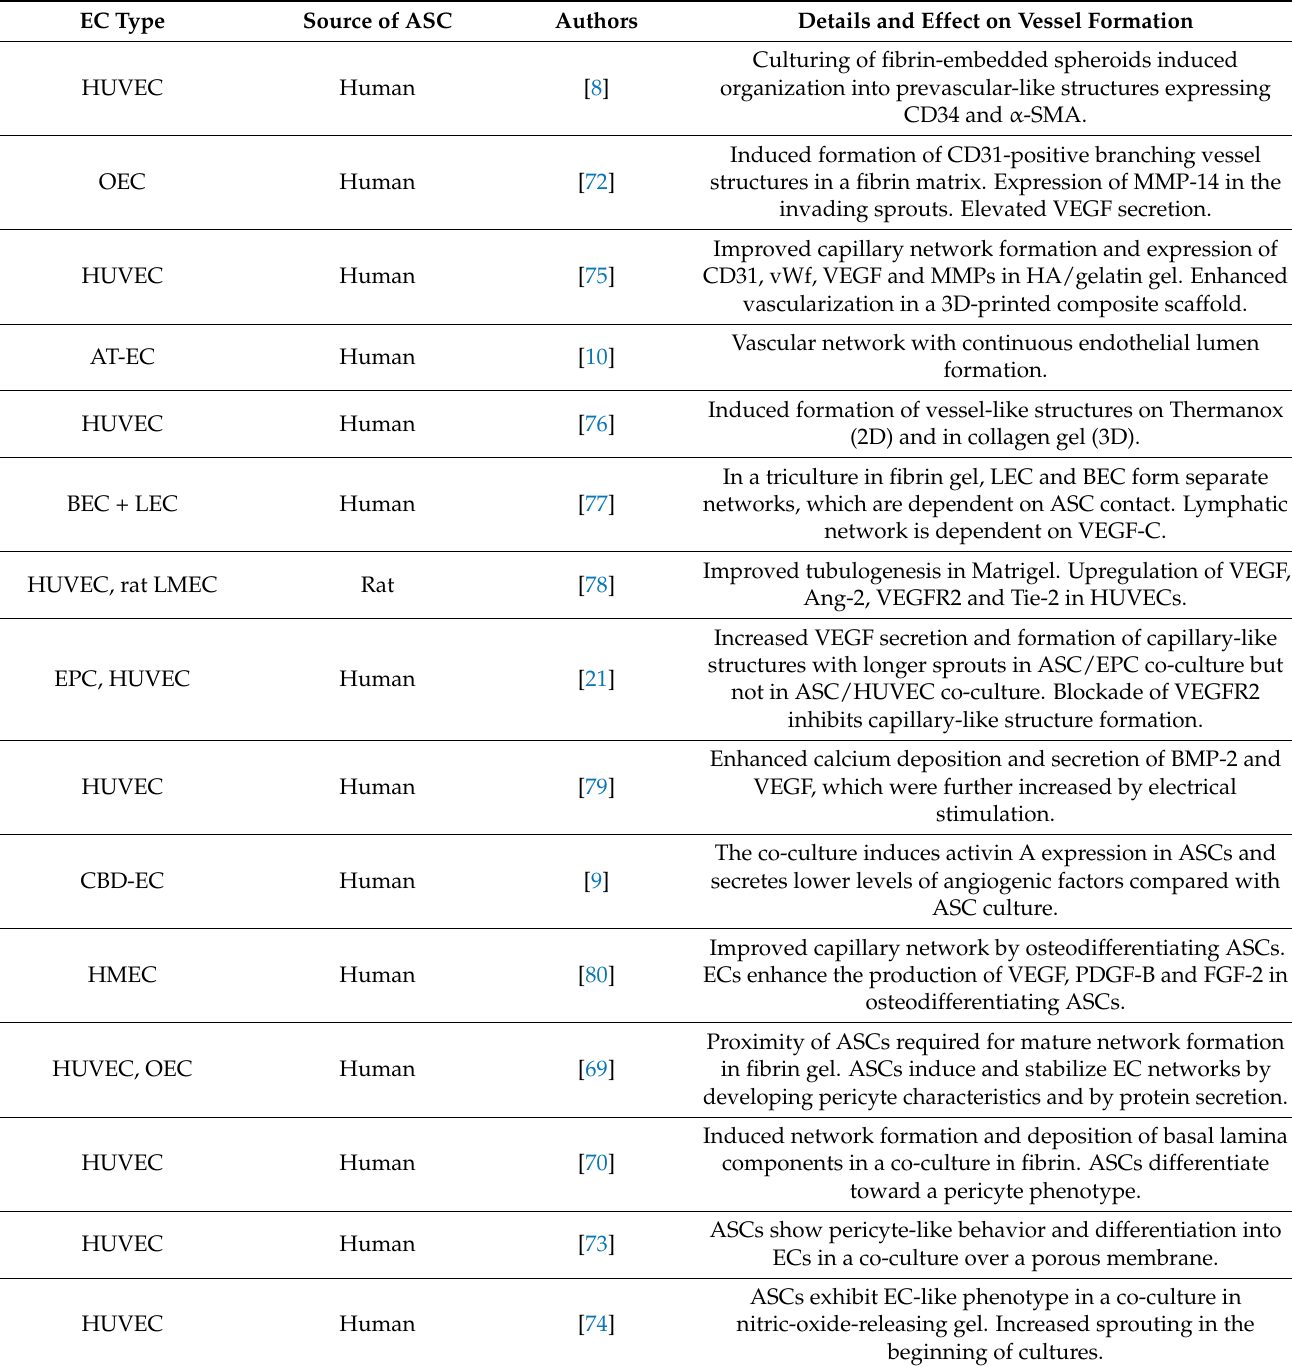
Table 2. Summary of in vitro studies involving co-culture of ASCs and endothelial cells to promote vascularization. EC